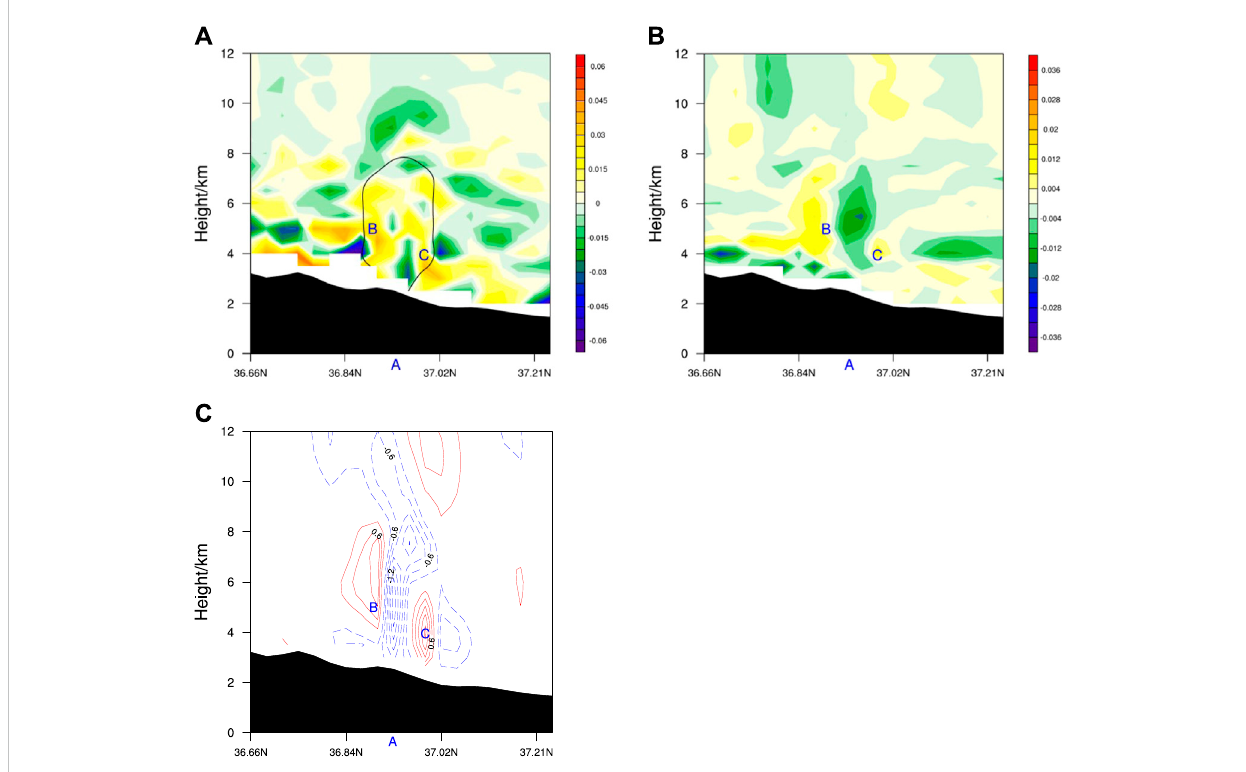
FIGURE 6 Cross sections of (A) the vertical gradient term of three-dimensional divergence (shadings, units: m s -3 ), (B) vertical pressure gradient force change (shadings,units: m s − 2 )and (C) vertical velocity change (shadings,units: m s − 1 )after 6 salong 78.91 ° E at0700 UTC on 15 June 2021. The labels “ B ” and “ C ” denote the positions corresponding to positive changes in VPGF and vertical velocity, respectively.